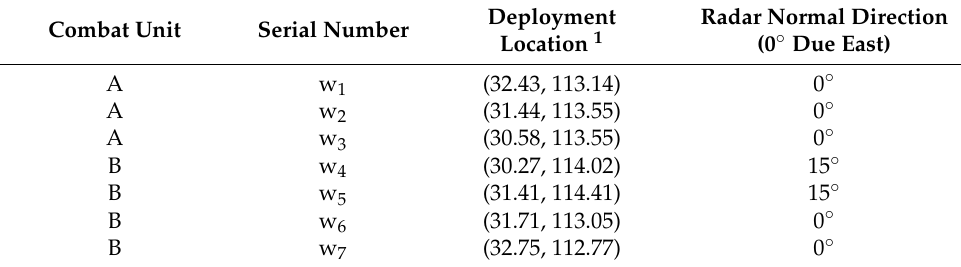
Table 4. Combat unit deployment location.